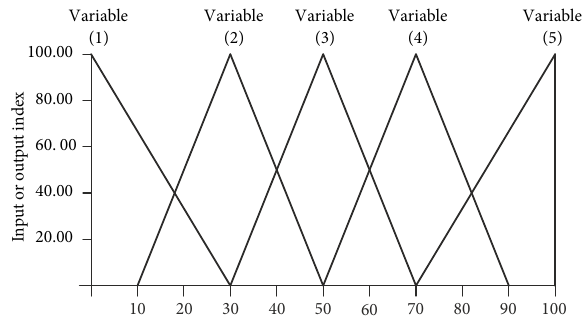
Figure 1. Membership function for inputs and